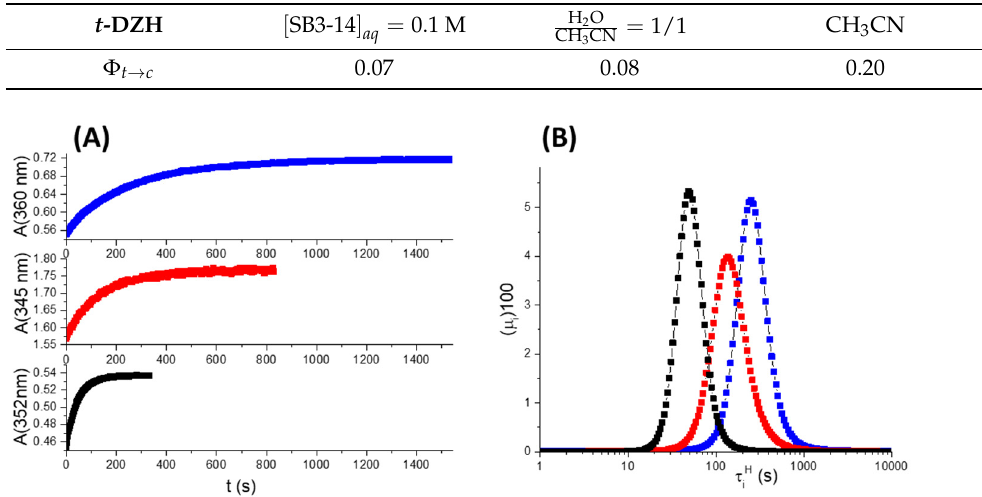
Table 3. Photochemical quantum yields Φ t → c for t -DZH in the three media. The relative uncertainties in the Φ t → c values are of the order of 5%.